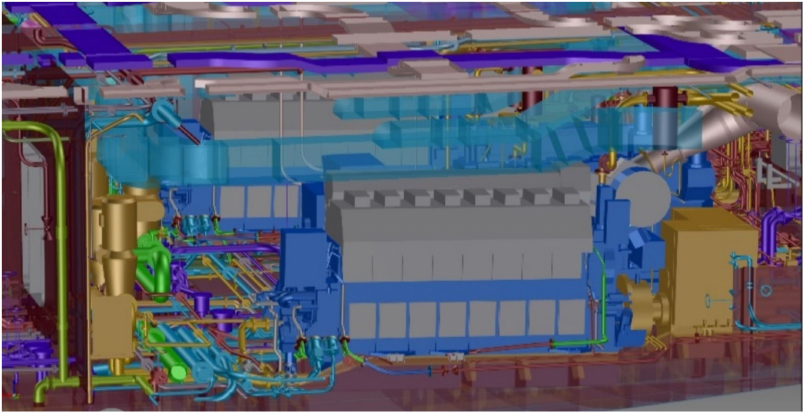
Figure 5. Detail view of an engine room of a ferry 3D